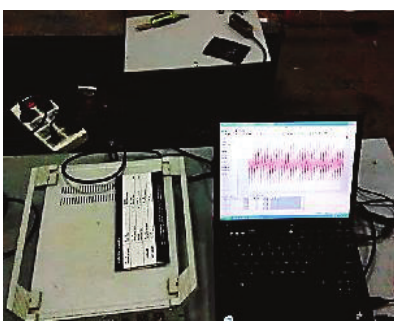
Figure 6: Data acquisition system.